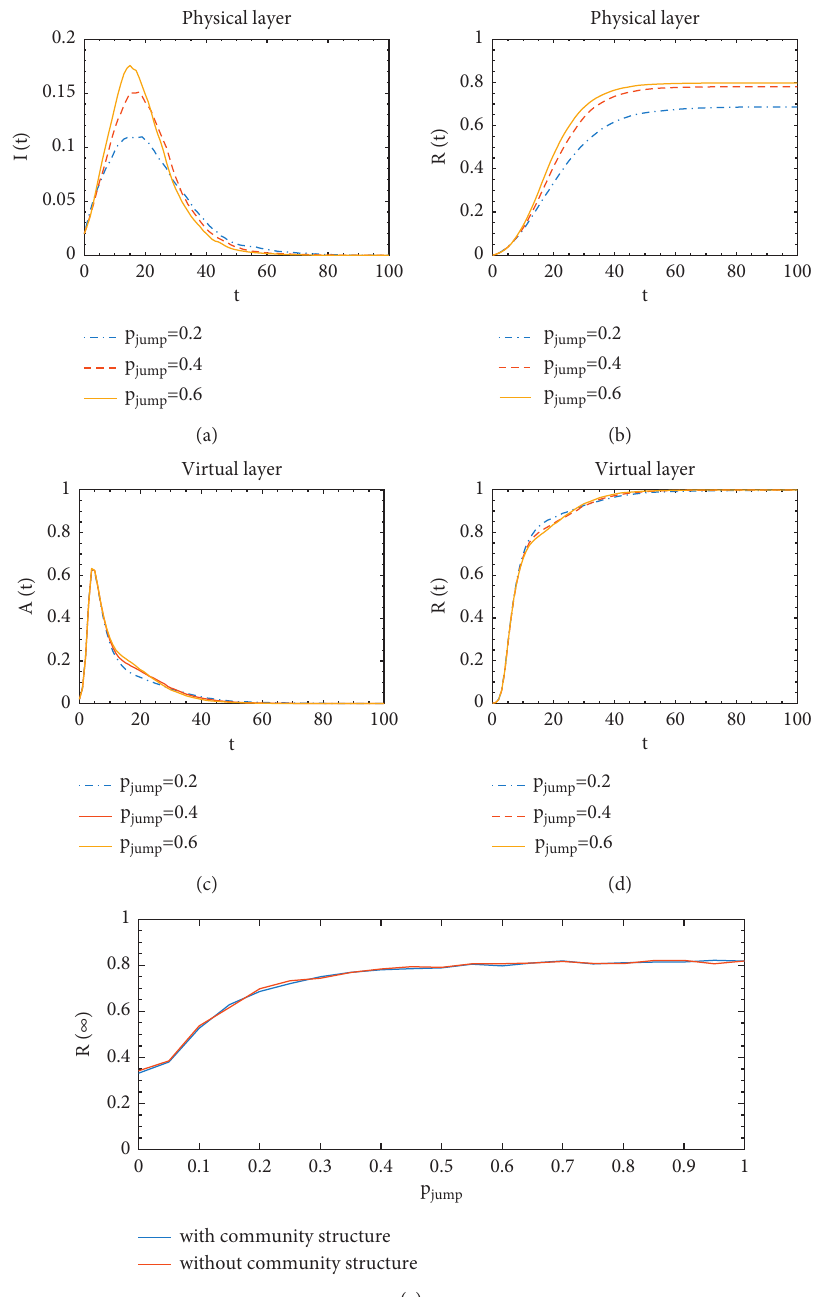
Figure 9: The influence of long-distance jump on the coupled disease-awareness model. (a) Density of infected individuals in the physical layer as a function of time. (b) Density of recovered individuals in the physical layer as a function of time. (c) Density of aware individuals in the virtual layer as a function of time. (d) Density of recovered individuals in the virtual layer as a function of time. (e) The final density of recovered individuals in the physical layer under different probabilities of jumping for the virtual contact networks with or without community